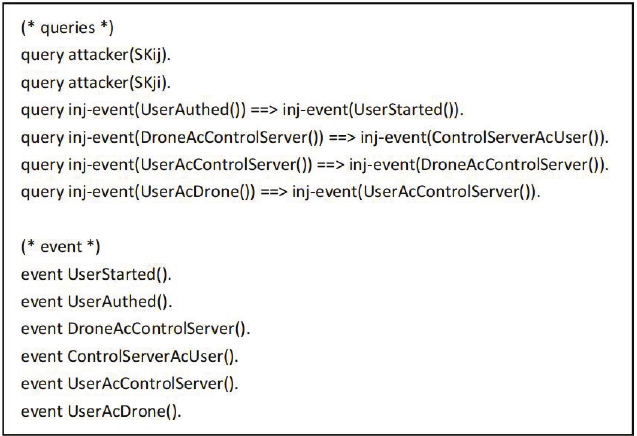
Figure 6. The queries and events in the ProVerif tool.